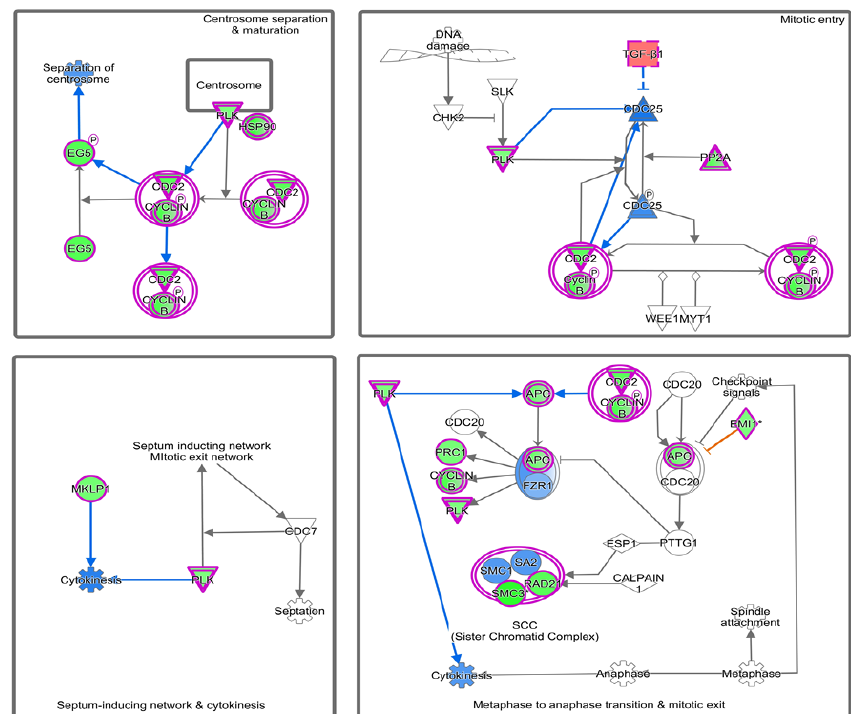
Figure 4. Significant inhibition of mitotic polo-like kinase pathway predicted by IPA. Pathway genes were overlaid to the DEGs; upregulated ( TGFB1 , CDC25 , FZR1 ) genes are shown in red/pink, while downregulated genes ( PRC1 , PLK , Cyclin B1 , SMC3 ) are shown in green.